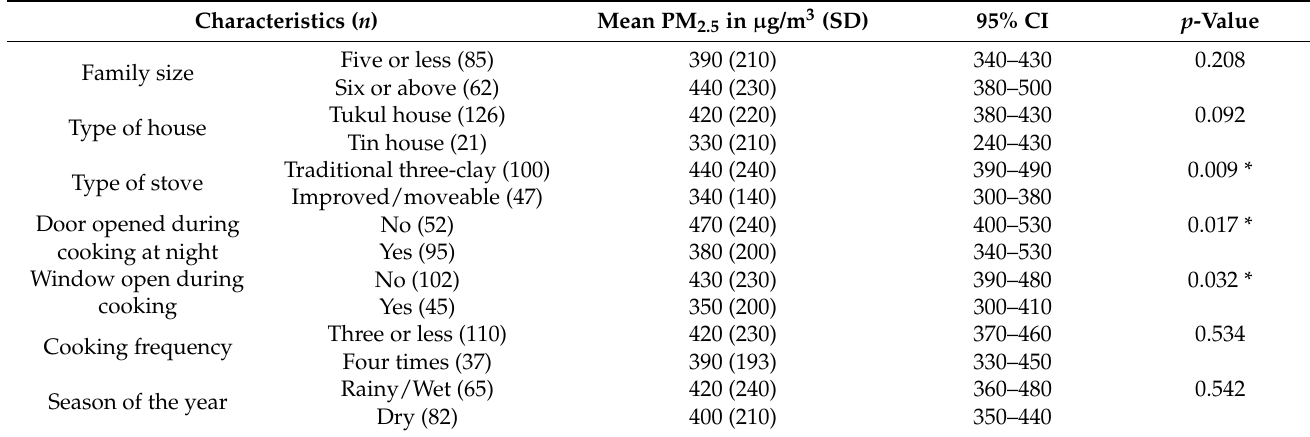
Table 2. Mean PM 2.5 concentration in relation to cooking and housing conditions.